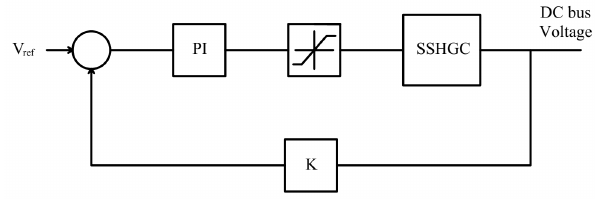
Figure 13. The closed-loop control system for DC